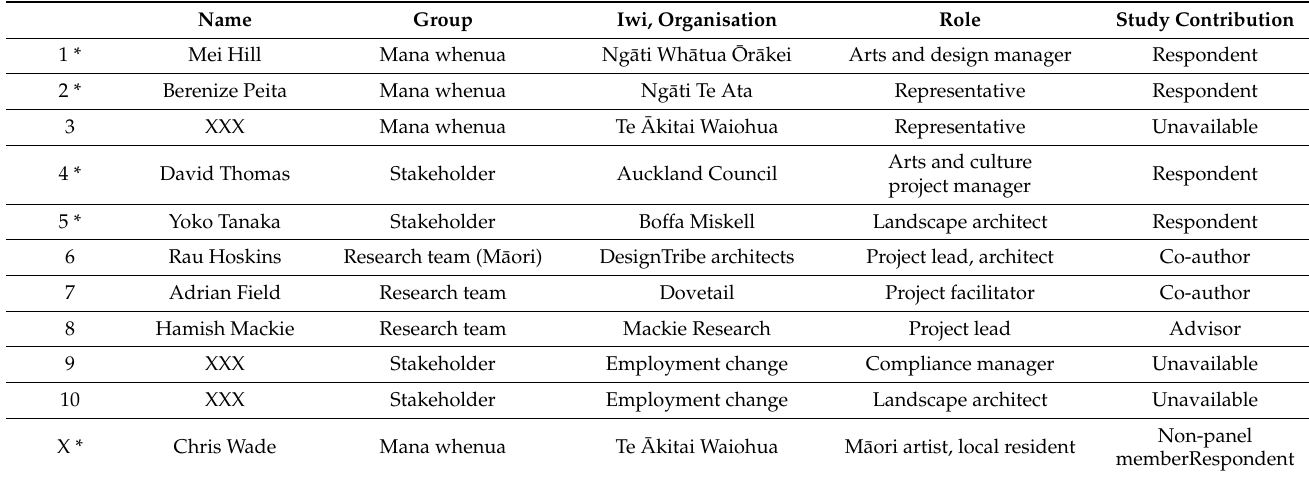
Table 1. Mana whenua co-design panel members with their roles in the panel and this